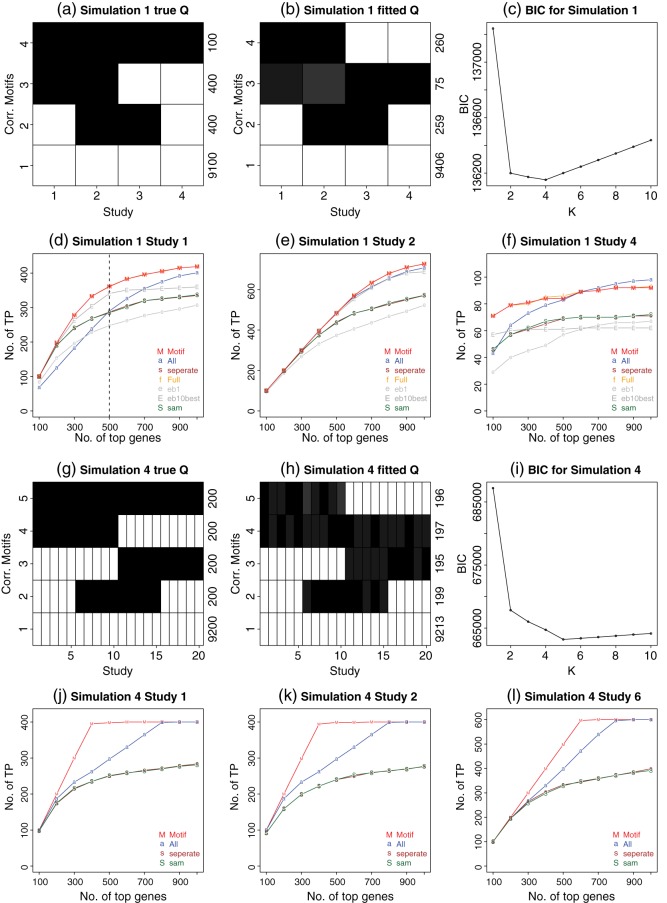
Results for the model assumption-based simulations (simulations 1 and 4). Also see supplemental Figure A.1 available at Biostatistics online for simulations 2 and 3. (a) and (g) True motif patterns for simulations 1 and 4. The \documentclass[12pt]{minimal}
\usepackage{amsmath}
\usepackage{wasysym}
\usepackage{amsfonts}
\usepackage{amssymb}
\usepackage{amsbsy}
\usepackage{upgreek}
\usepackage{mathrsfs}
\setlength{\oddsidemargin}{-69pt}
\begin{document}
}{}$\boldsymbol{Q}$\end{document} of the true motifs is shown. Each row indicates a motif pattern and each column represents a study. The actual number of genes belonging to each motif (i.e. \documentclass[12pt]{minimal}
\usepackage{amsmath}
\usepackage{wasysym}
\usepackage{amsfonts}
\usepackage{amssymb}
\usepackage{amsbsy}
\usepackage{upgreek}
\usepackage{mathrsfs}
\setlength{\oddsidemargin}{-69pt}
\begin{document}
}{}$\boldsymbol {\pi }*G$\end{document}) is displayed at the right end of each row. The gray scale of the cell \documentclass[12pt]{minimal}
\usepackage{amsmath}
\usepackage{wasysym}
\usepackage{amsfonts}
\usepackage{amssymb}
\usepackage{amsbsy}
\usepackage{upgreek}
\usepackage{mathrsfs}
\setlength{\oddsidemargin}{-69pt}
\begin{document}
}{}$(k,d)$\end{document} demonstrates the probability of differential expression in study \documentclass[12pt]{minimal}
\usepackage{amsmath}
\usepackage{wasysym}
\usepackage{amsfonts}
\usepackage{amssymb}
\usepackage{amsbsy}
\usepackage{upgreek}
\usepackage{mathrsfs}
\setlength{\oddsidemargin}{-69pt}
\begin{document}
}{}$d$\end{document} for pattern \documentclass[12pt]{minimal}
\usepackage{amsmath}
\usepackage{wasysym}
\usepackage{amsfonts}
\usepackage{amssymb}
\usepackage{amsbsy}
\usepackage{upgreek}
\usepackage{mathrsfs}
\setlength{\oddsidemargin}{-69pt}
\begin{document}
}{}$k$\end{document}. Black means 1 and white means 0. (b) and (h) The estimated \documentclass[12pt]{minimal}
\usepackage{amsmath}
\usepackage{wasysym}
\usepackage{amsfonts}
\usepackage{amssymb}
\usepackage{amsbsy}
\usepackage{upgreek}
\usepackage{mathrsfs}
\setlength{\oddsidemargin}{-69pt}
\begin{document}
}{}$\hat {\boldsymbol{Q}}$\end{document} from the learned motifs with \documentclass[12pt]{minimal}
\usepackage{amsmath}
\usepackage{wasysym}
\usepackage{amsfonts}
\usepackage{amssymb}
\usepackage{amsbsy}
\usepackage{upgreek}
\usepackage{mathrsfs}
\setlength{\oddsidemargin}{-69pt}
\begin{document}
}{}$\hat {\boldsymbol {\pi }}*G$\end{document} annotated at the end of each row. (c) and (i) BIC plots. It can be seen that motif patterns reported by CorMotif under the minimal BIC are similar to the true underlying motif patterns. (d)–(f) and (j)–(l) Gene ranking performance of different methods in simulations 1 and 4. \documentclass[12pt]{minimal}
\usepackage{amsmath}
\usepackage{wasysym}
\usepackage{amsfonts}
\usepackage{amssymb}
\usepackage{amsbsy}
\usepackage{upgreek}
\usepackage{mathrsfs}
\setlength{\oddsidemargin}{-69pt}
\begin{document}
}{}${\mathrm {TP}}_d(r)$\end{document}, the number of genes that are truly differentially expressed in study \documentclass[12pt]{minimal}
\usepackage{amsmath}
\usepackage{wasysym}
\usepackage{amsfonts}
\usepackage{amssymb}
\usepackage{amsbsy}
\usepackage{upgreek}
\usepackage{mathrsfs}
\setlength{\oddsidemargin}{-69pt}
\begin{document}
}{}$d$\end{document} among the top \documentclass[12pt]{minimal}
\usepackage{amsmath}
\usepackage{wasysym}
\usepackage{amsfonts}
\usepackage{amssymb}
\usepackage{amsbsy}
\usepackage{upgreek}
\usepackage{mathrsfs}
\setlength{\oddsidemargin}{-69pt}
\begin{document}
}{}$r$\end{document} ranked genes by a given method, is plotted against the rank cutoff \documentclass[12pt]{minimal}
\usepackage{amsmath}
\usepackage{wasysym}
\usepackage{amsfonts}
\usepackage{amssymb}
\usepackage{amsbsy}
\usepackage{upgreek}
\usepackage{mathrsfs}
\setlength{\oddsidemargin}{-69pt}
\begin{document}
}{}$r$\end{document}. For each simulation, results for a few representative studies are shown. Each plot is for one study.